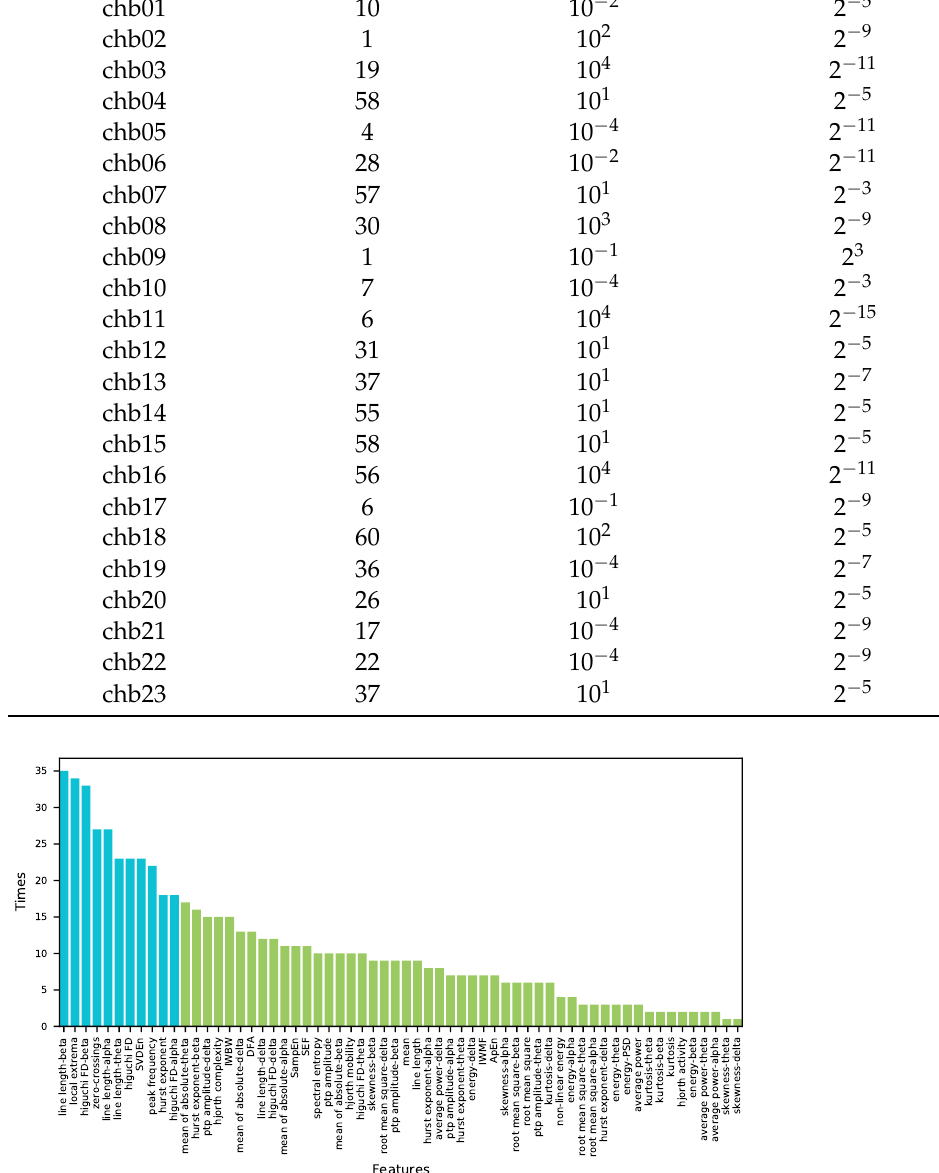
Figure 5. Times of feature appearance in optimal channel-based feature combinations. The top 11 of 62 features with sky-blue bar are regarded as summarized